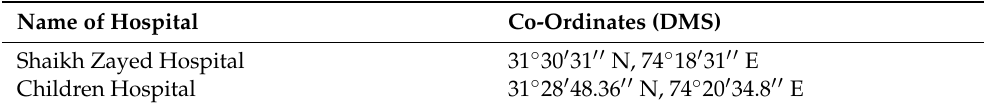
Table 2. Co-ordinates of the sampling hospitals. Name of